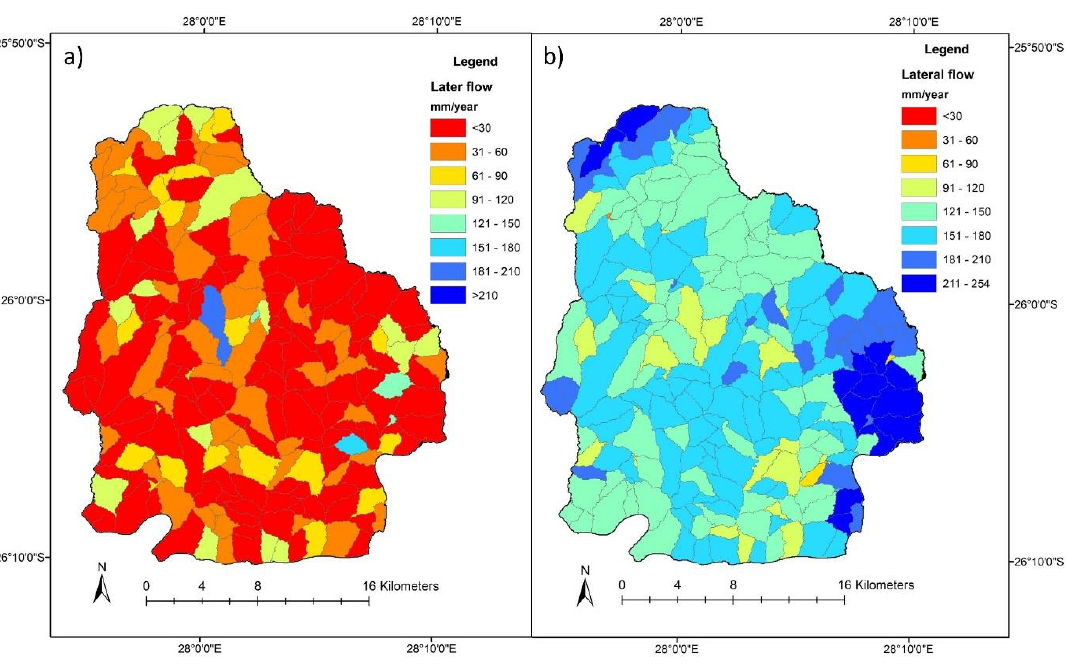
Figure 6. Simulated lateral flow (mm.year − 1 ) at landscape unit scale for the ( a ) LT and ( b ) DSM simulations.